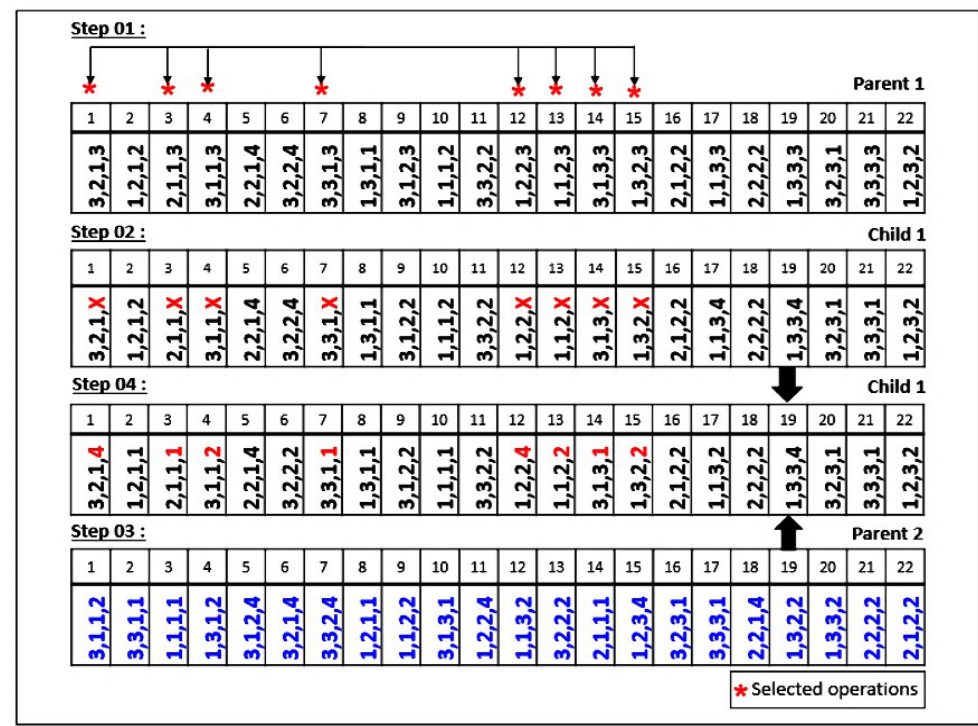
Figure 4. OMAC (operation to machine assignment crossover)